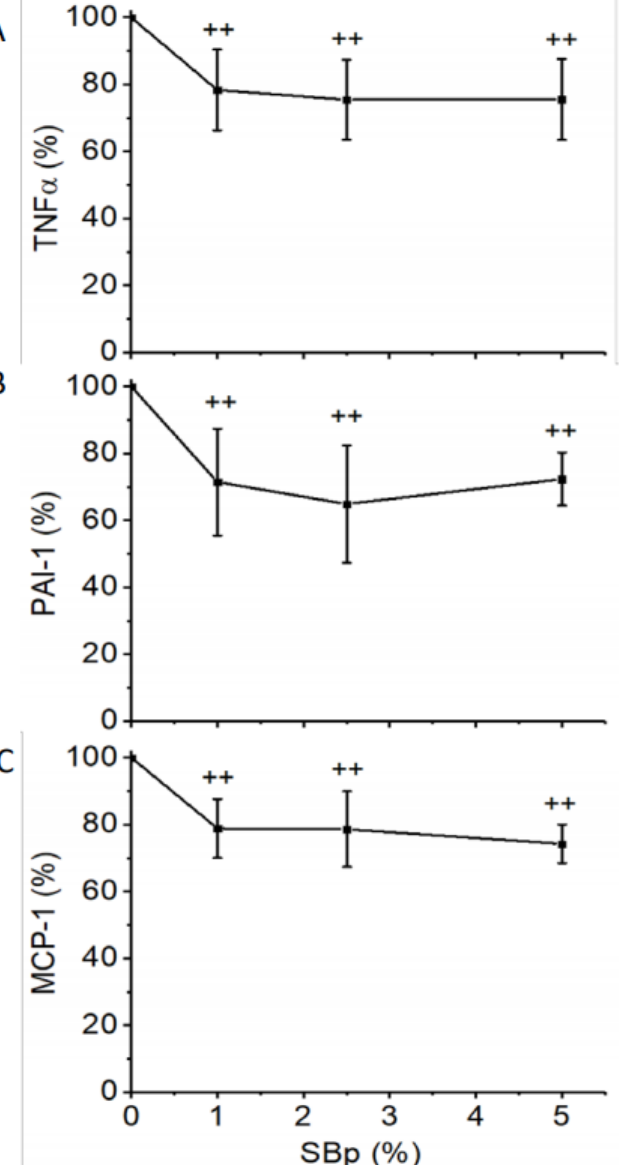
Figure 3. Levels of inflammatory regulators in plasma of mice receiving HFHS diet supplemented with 0–5% SBp. The experimental regimen is described in the legend of Figure 1. Tumor necrosis factor- α (TNF α in A ), plasminogen activator inhibitor-1 (PAI-1 in B ) and monocyte chemotactic protein-1 (MCP-1 in C ) were analyzed in plasma collected at the end of the intervention. Relative changes in the inflammatory markers were expressed in mean ± SD % ( n = 8/group) vs. HFHS group. ++: p < 0.01 vs. the HFHS group.